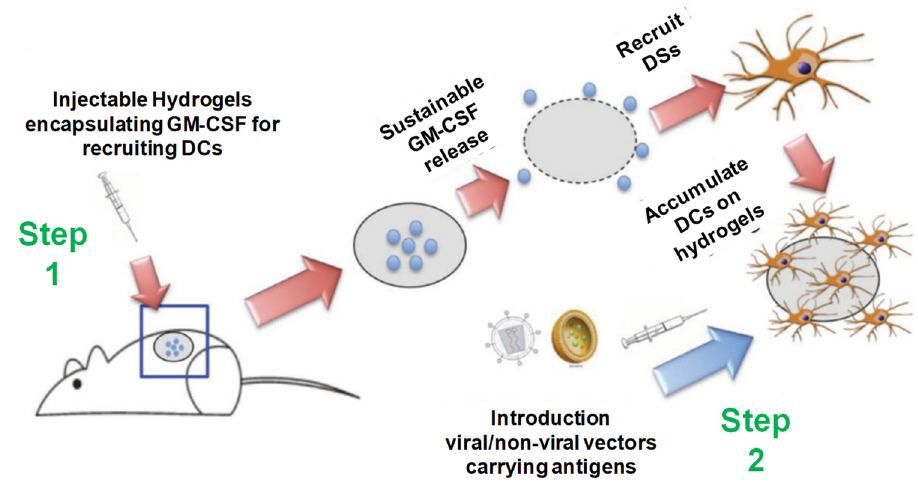
Figure 20. Injectable thermosensitive hydrogels for cancer vaccines. Step 1: Sustainable release of GM-CSF from the injectable thermosensitive mPEG- PLGA hydrogels recruits host dendritic